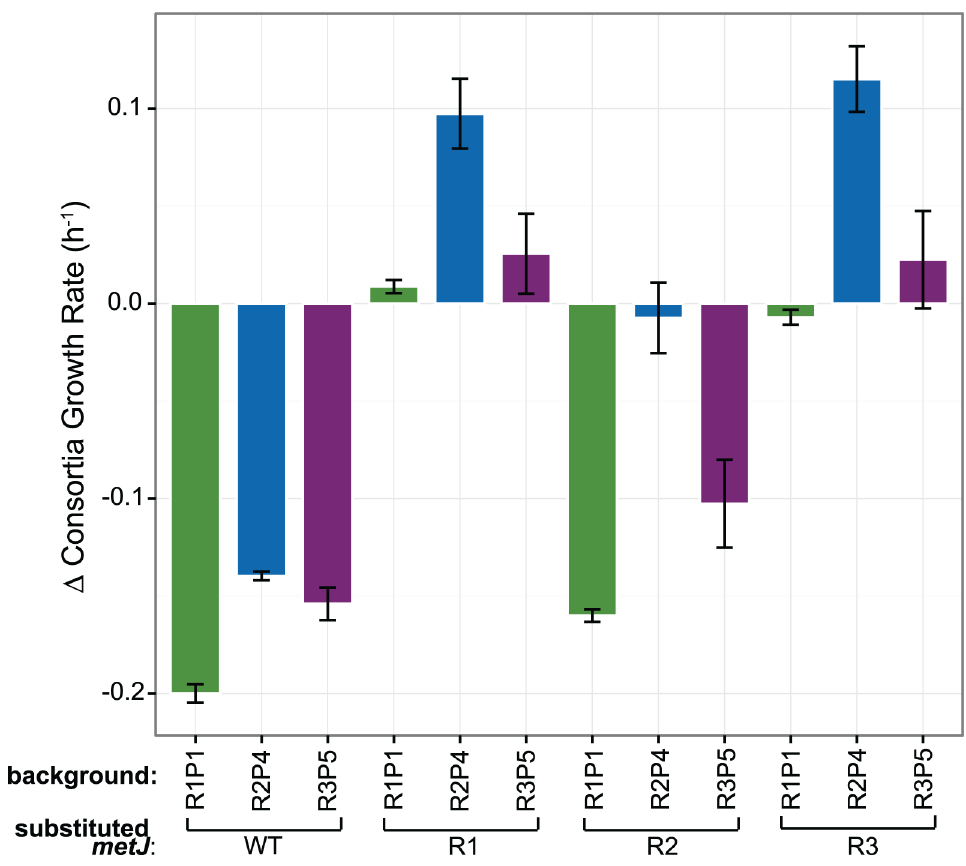
Fig 8. The effect of metJ alleles on cooperation in different S . enterica genetic backgrounds. Mean growth rate of each cooperator with no metJ substitutionwas subtracted from measuredconsortia growth rates with substituted metJ . Error bars represent standard error of three